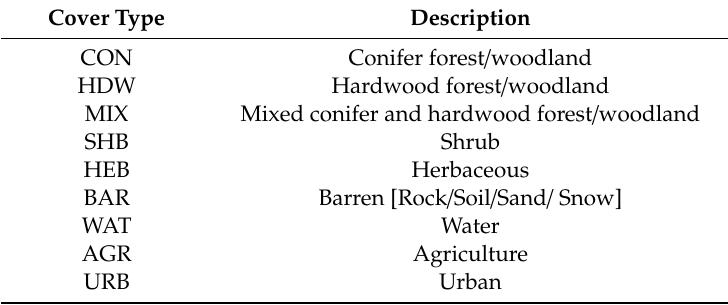
Table 2. Vegetation cover types defined within U.S. Forest Service’s vegetation map of California (CALVEG)